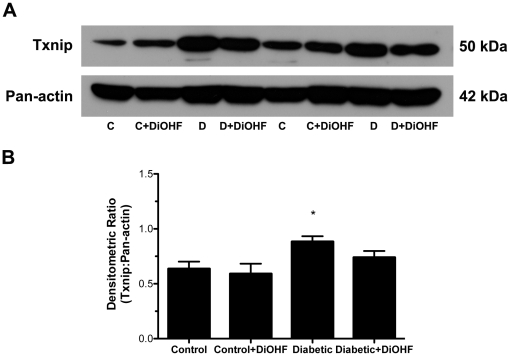
Txnip protein expression.(A) Representative western blot and (B) quantitation of Txnip normalized to loading control pan-actin. The significant increase in Txnip protein in diabetic rats was moderately reduced by DiOHF treatment. Data expressed as mean ± SE. *P<0.05 vs control (non-diabetic) rats.